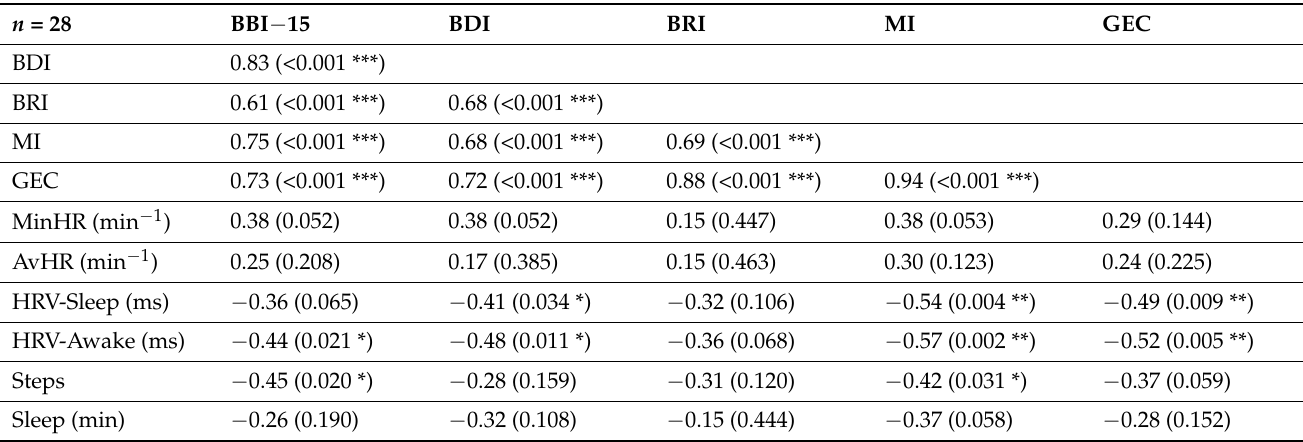
Table 3. Spearman ´ s partial rank correlation coefficients and statistical significances for BBI − 15 score, BDI score, BRIEF-A indices, and Firstbeat ® results with gender controlled for ( p < 0.05 (*), p < 0.01 (**), and p < 0.001 (***)).